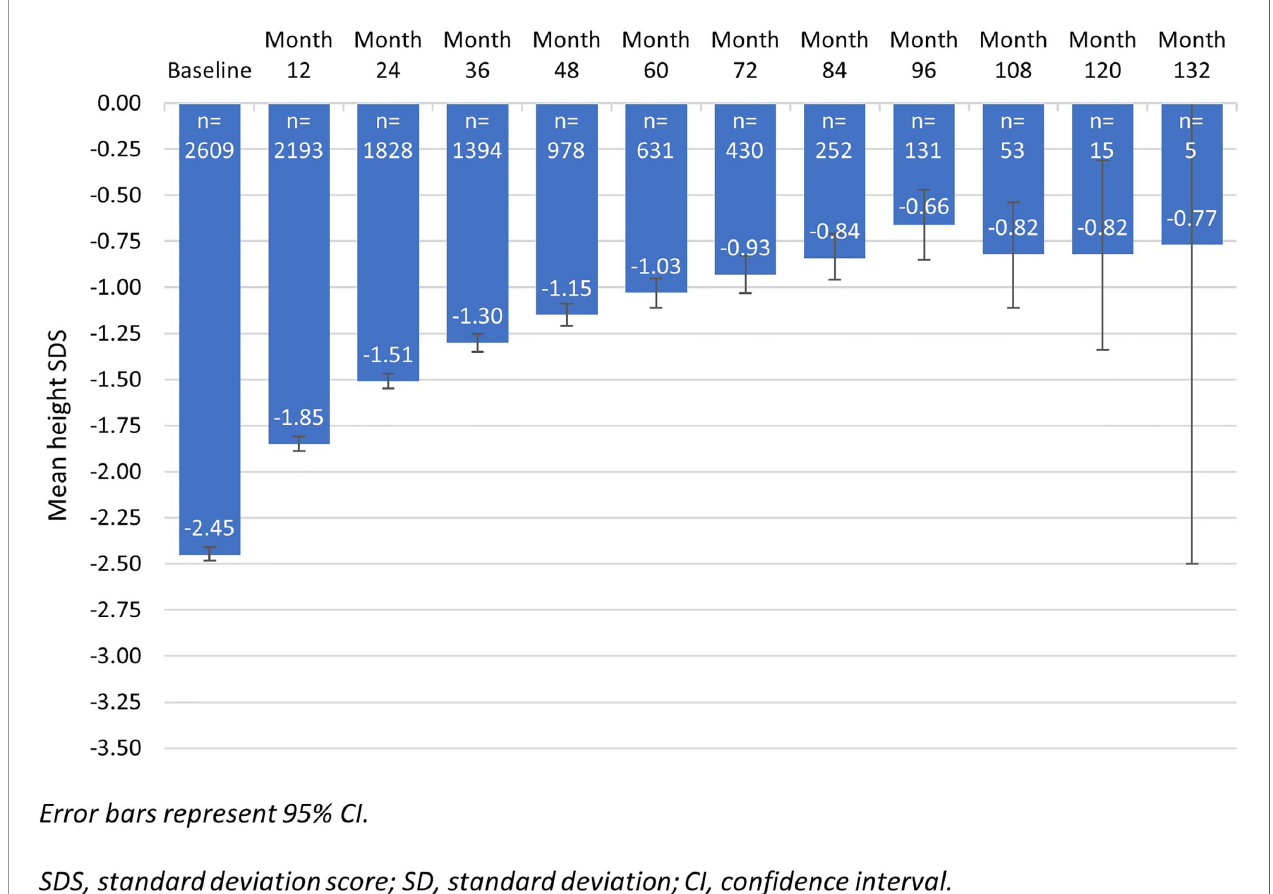
FIGURE 2 | Evolution of height SDS from baseline to month 132 – Registry population